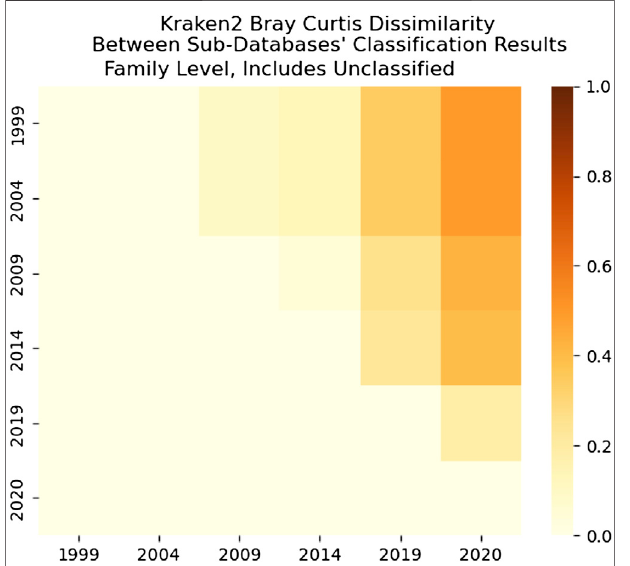
FIGURE 19 | Kraken 2 ’ s Bray-Curtis Dissimilarity score for Genus level between each sub-databases ’ classi fi cation results. The comparison shows that classi fi ed results are more similar for successive databases – although some are more similar than others (such as 1999 – 2004 and 2009 –